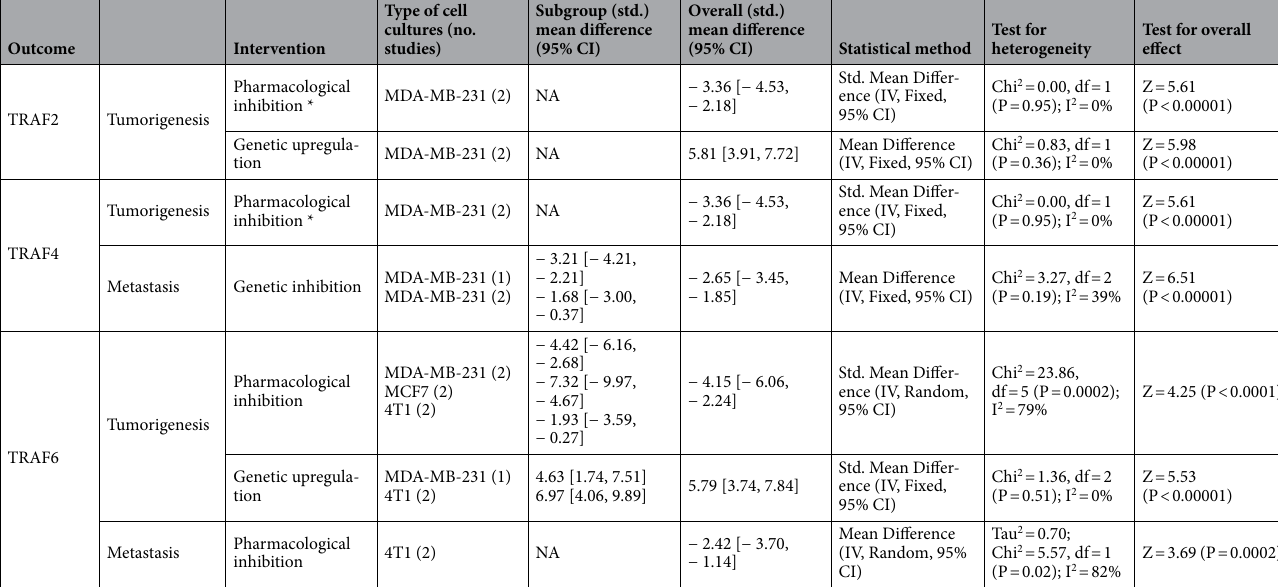
Table 3. Summary of meta-analysis of included studies showing significant association of in vivo tumour burden and overt metastasis with modulation of TRAF2/4/6. The analysis shows the mean difference or standard mean difference of different studies comparing the effects of the TRAF2/4/6 pharmacological inhibition, genetic inhibition or upregulation on tumour (weight (gram)/volume, %) and overt metastasis (histology and bioluminescence imaging). Std., standardised; IV, inverse-variance weighting; NA, not applicable. * intervention modulated the activity of both TRAF2 and